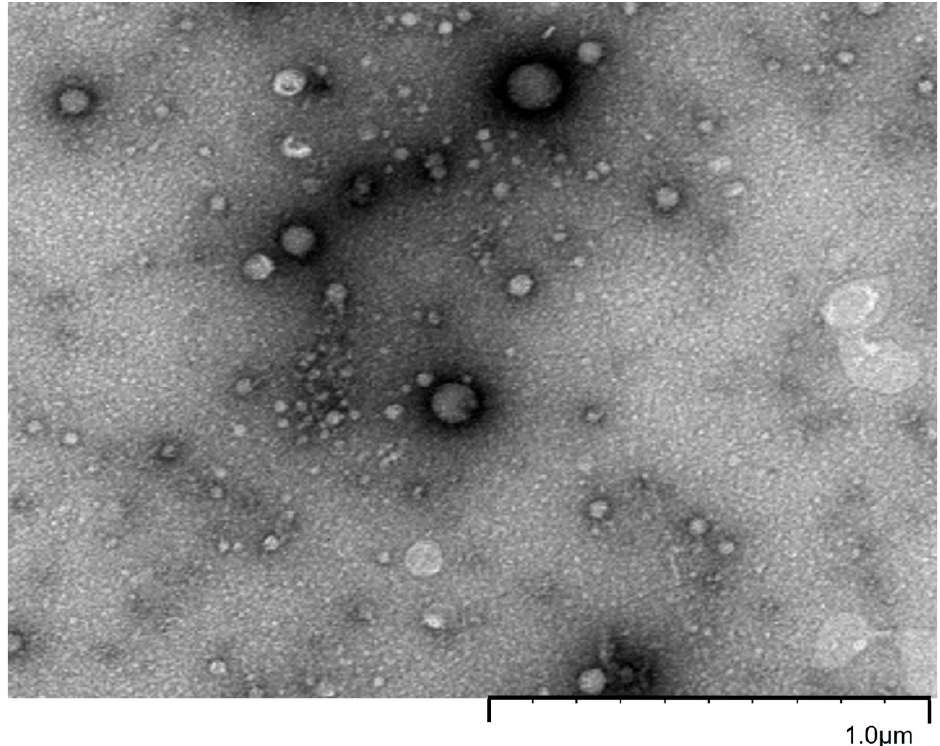
Figure 2. Transmission electron micrograph of EVs obtained from the crude fraction of cMSCs. The sample was then puri fi ed using the qEV35 size exclusion cartridge